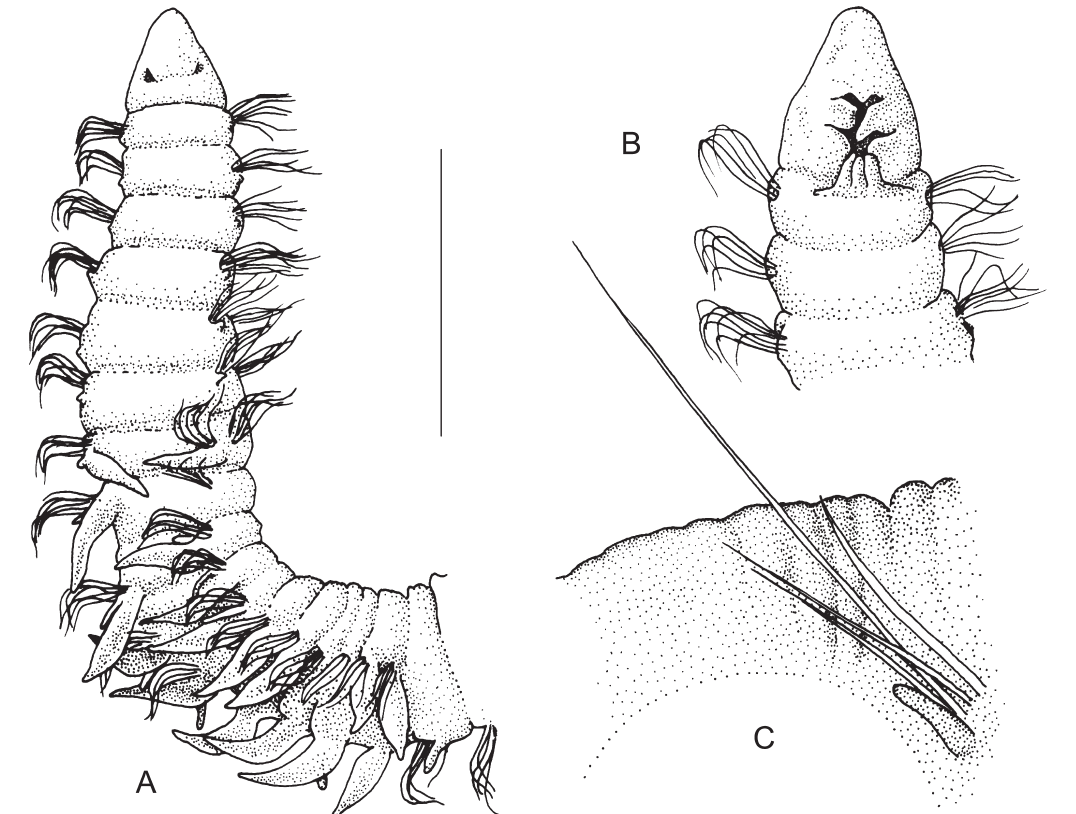
Fig . 8. – Paradoneis drachi : A, anterior region, dorsal view; b, anterior region, ventral view; c, notopodium, chaetiger 36. Scale bar: A 405 µ m; b 265 µ m; c 65 µ